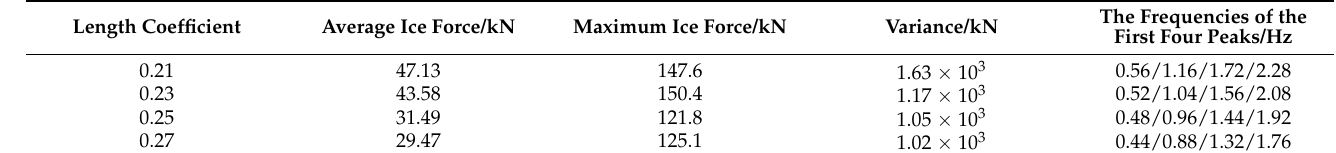
Table 5. Statistics of ice force under different length coefficients ( C l ).